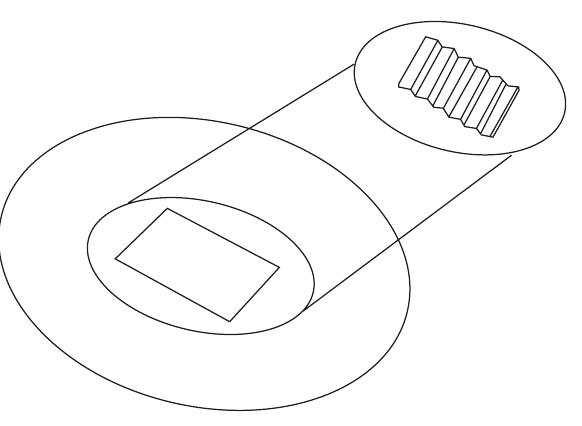
Figure 6: Magnetophoresis.